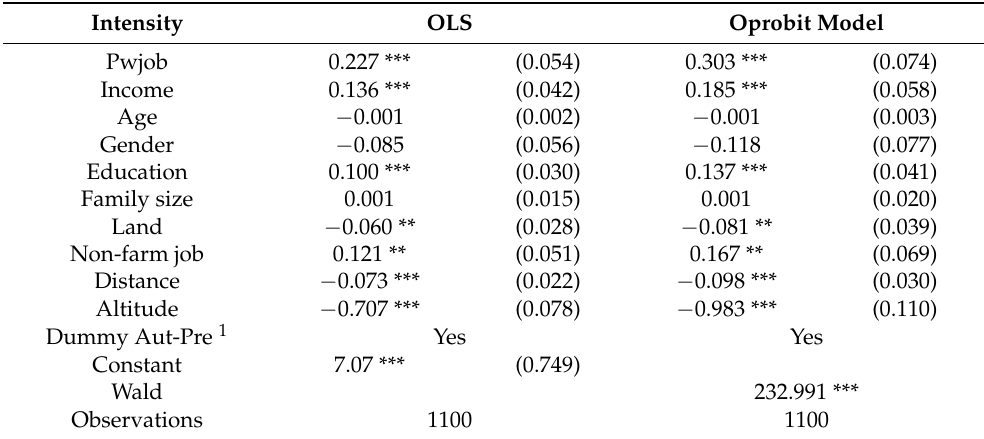
Table 2. The Ordered Probit regression